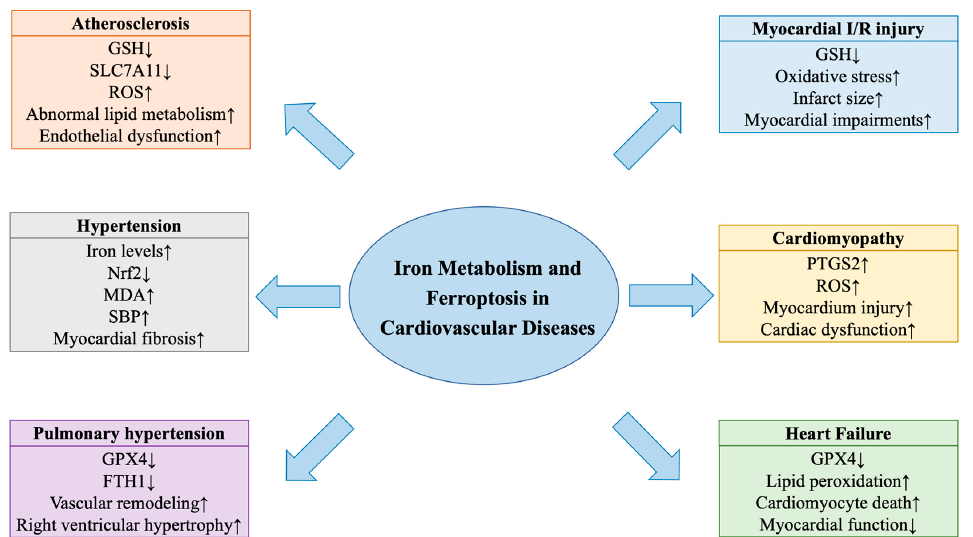
Figure 1. Iron metabolism and ferroptosis in cardiovascular diseases. FTH1, ferritin heavy chain 1; GPX4, glutathione peroxidase 4; GSH, glutathione; I/R, ischemia/reperfusion; MDA, malondialde- hyde; Nrf2, nuclear factor erythroid 2-related factor 2; PTGS2, prostaglandin endoperoxide synthase 2; ROS, reactive oxygen species; SBP, systolic blood pressure; SLC7A11, subunit solute carrier family 7 member 11; ↑ upregulation, ↓ downregulation.